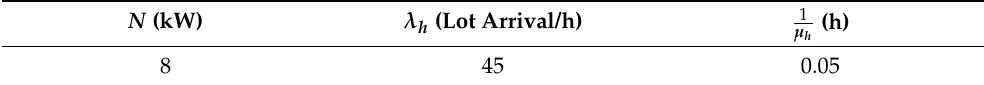
Table 3. Lot size, arrival rate and service rate of M n /M/ ∞ model. N (kW)